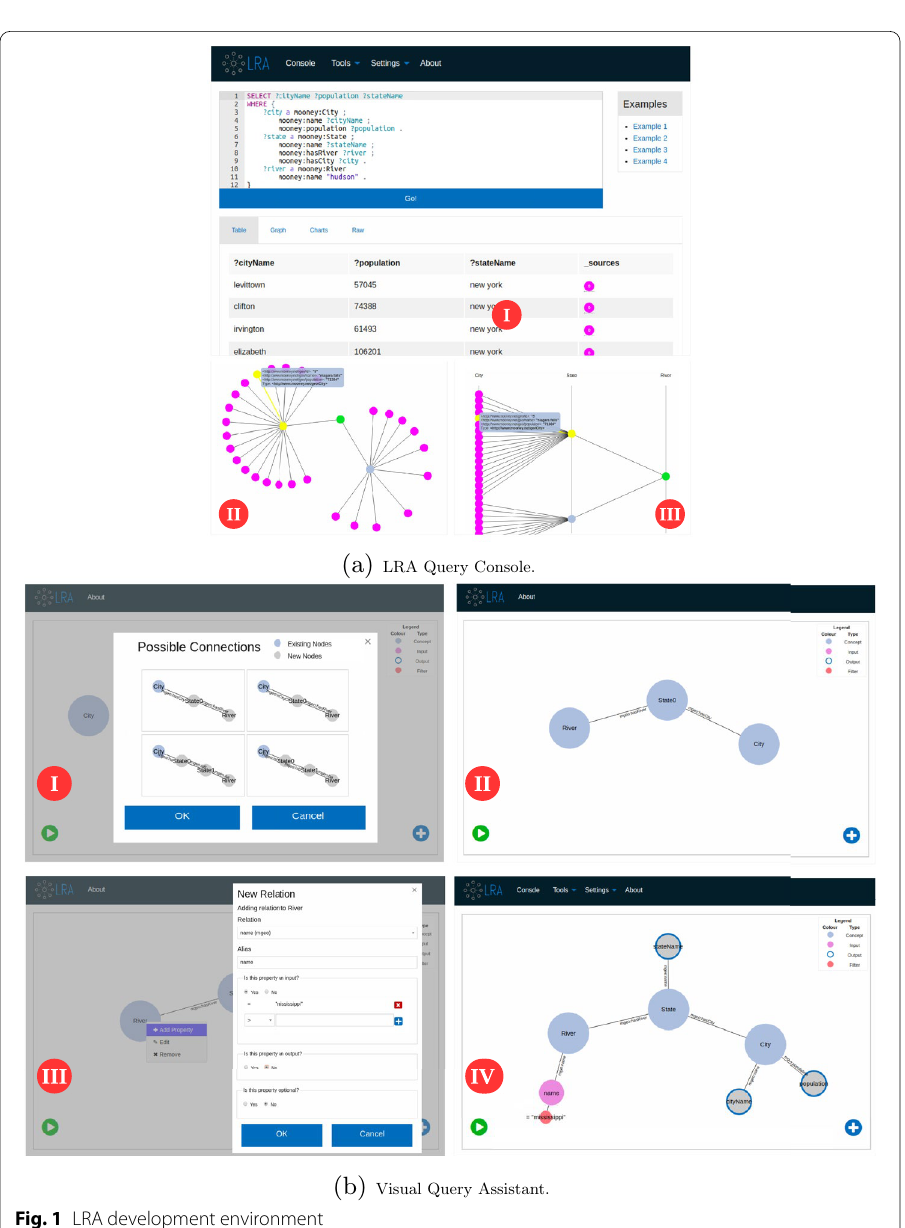
Fig. 1 LRA development